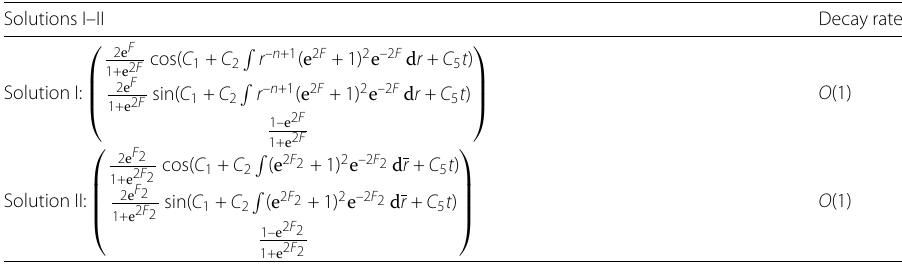
Table 3 Variable separation solution of the LLG equation without damping (see equation (59)). F is the solution of (71); F 2 satisfies (99)